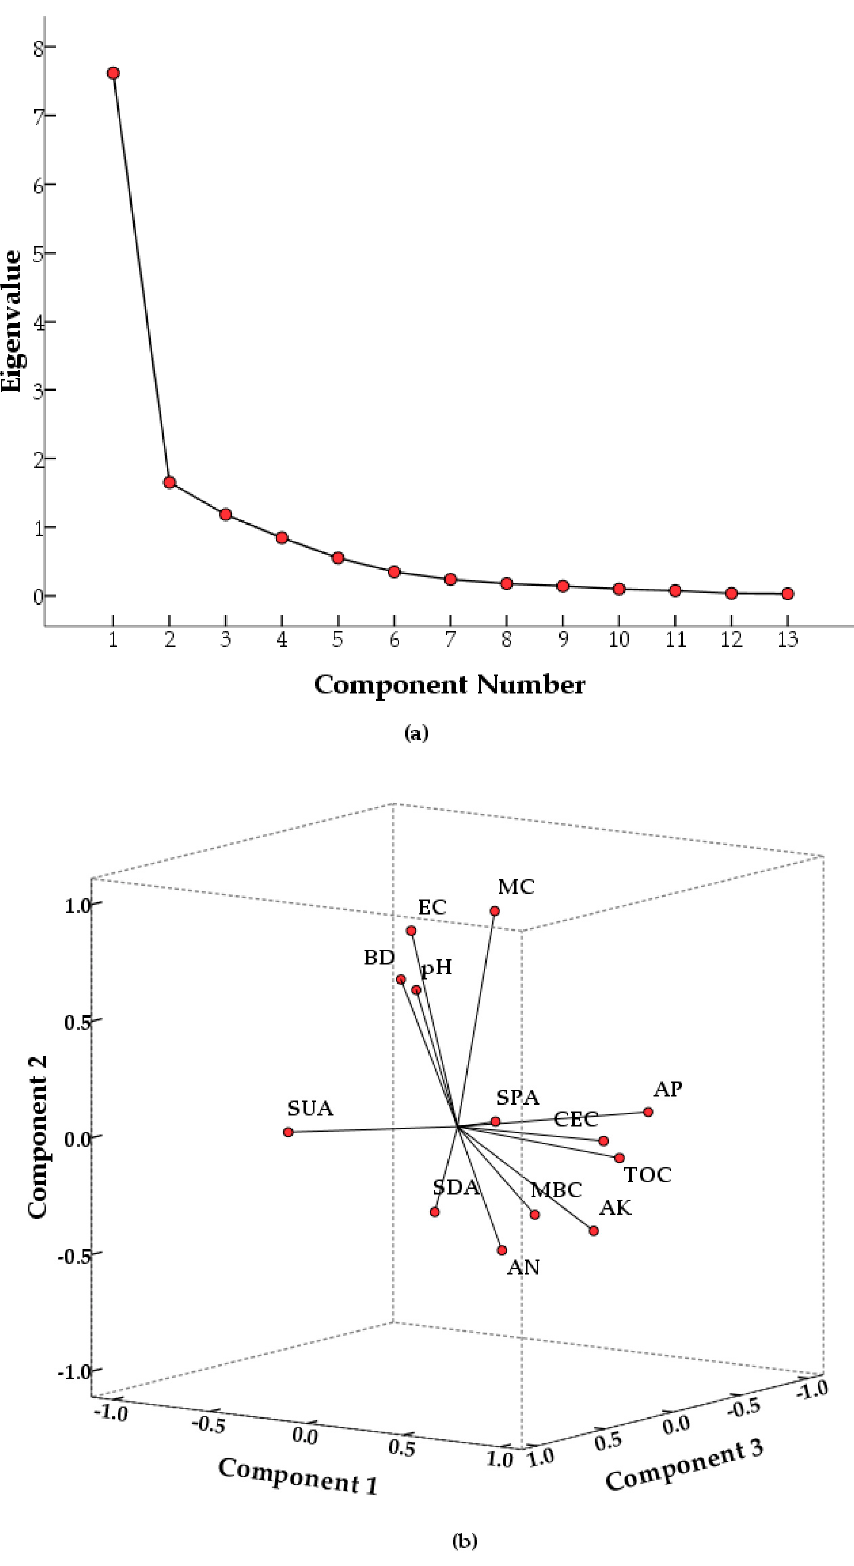
Figure 4. ( a ) Scree plot for the di ff erent components considered for the principal component analysis with eigenvalues greater than 1 and ( b ) component plot in the rotated space depicting the factor loading on the respective